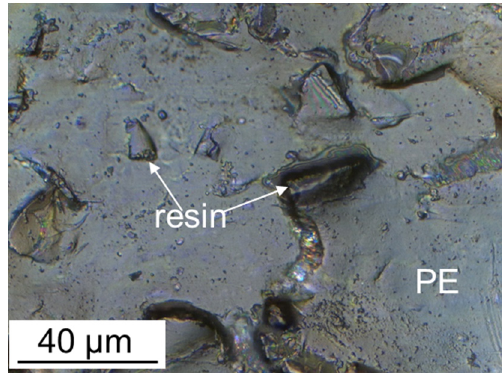
Figure 7. Optical image of the surface of the swollen MA ‐ 41 heterogeneous membrane; ′′ PE ′′ is the polyethylene binder, ′′ resin ′′ is the ion ‐ exchange resin particle protruding over the polyethylene film (redrawn from [36]).